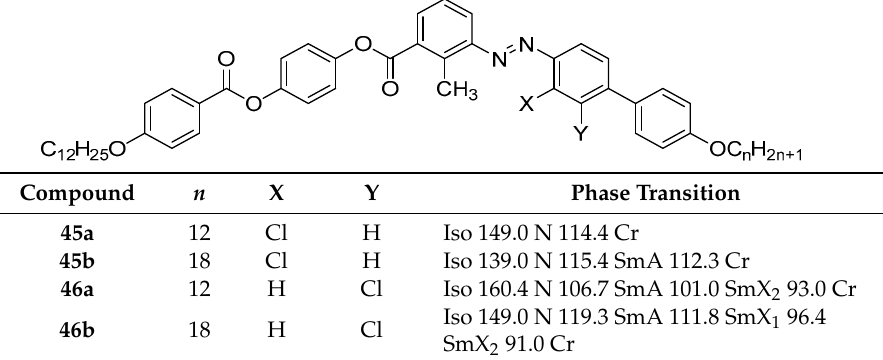
Table 10. Phase transition of compounds 45 and 46 .